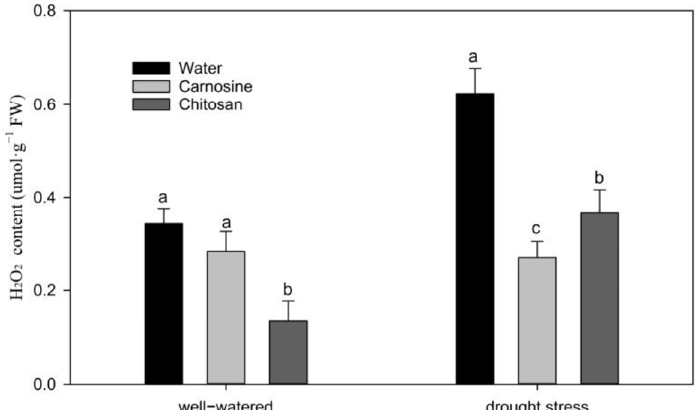
Figure 9. Effects of carnosine and chitosan on H 2 O 2 content in bermudagrass. ‘Water’ represents control plants sprayed with distilled water under both well-watered and drought stress. The columns represent the means and standard errors (SE) of 5 replicates. The different letters represent a significant difference among treatments at the same time point at p < 0.05.